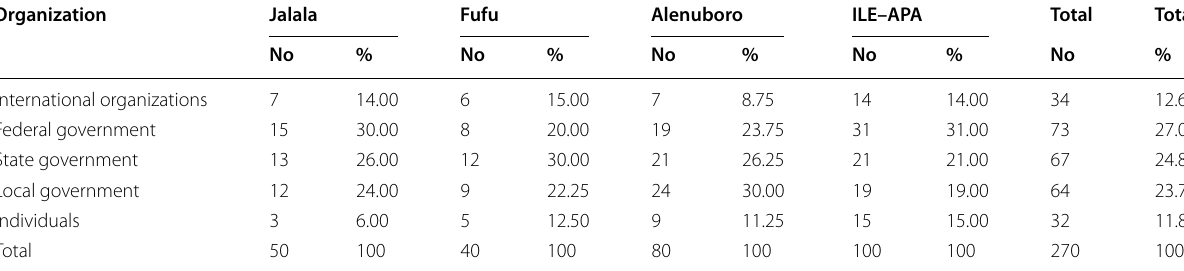
Table 10 Who has the responsibility of tackling climate change?